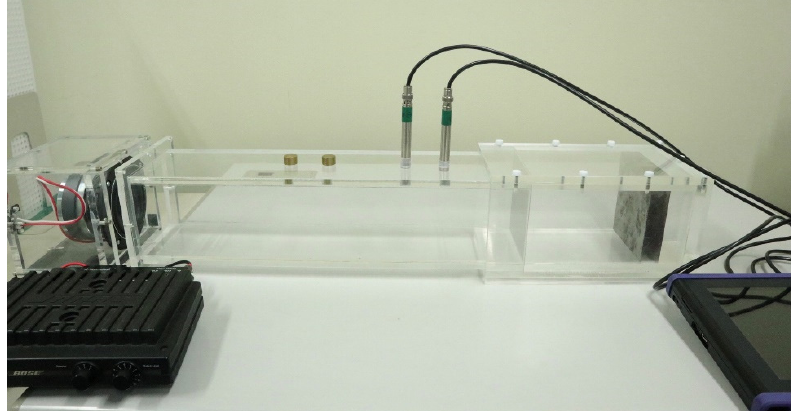
Figure 5. A photograph of the measurement setup using an impedance tube.